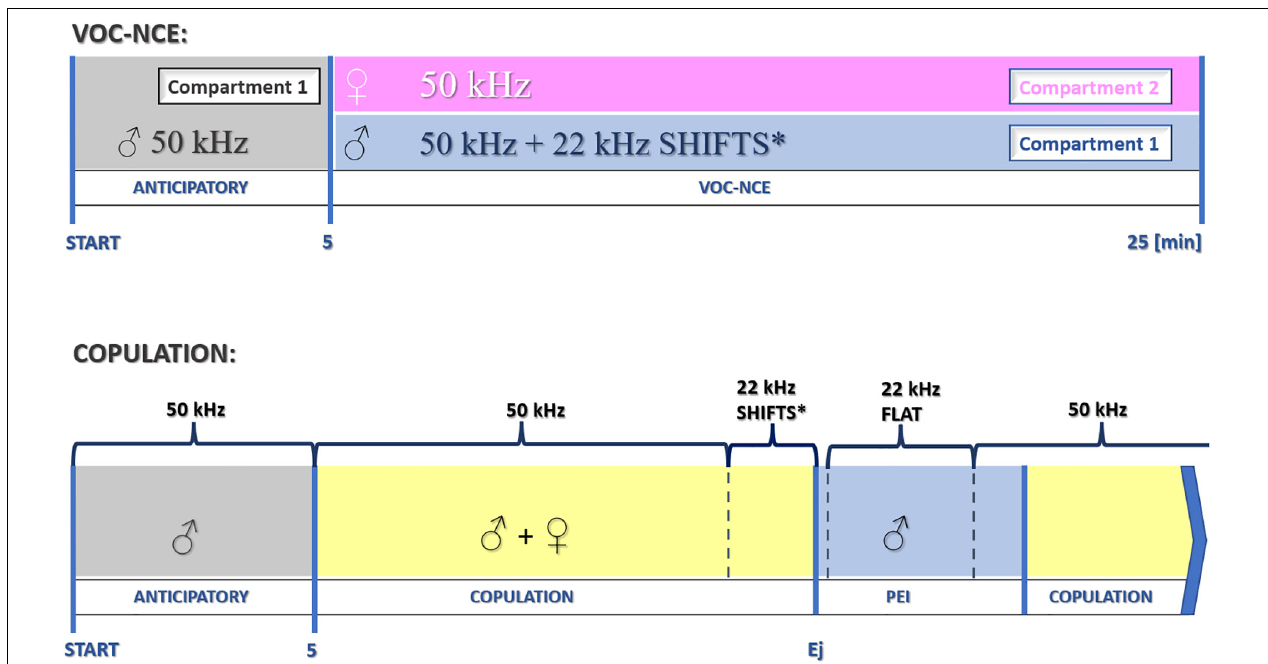
FIGURE 10 | Schematic protocol for the investigation of USV during particular phases of sociosexual interactions. *22-kHz shifts in the late phase of copulation occur relatively rarely. After the dominant flat-type postejaculatory 22-kHz signal, some forms of modulation could also be observed (end phase of 22-kHz postejaculatory vocalization, not depicted in the figure). Ej,